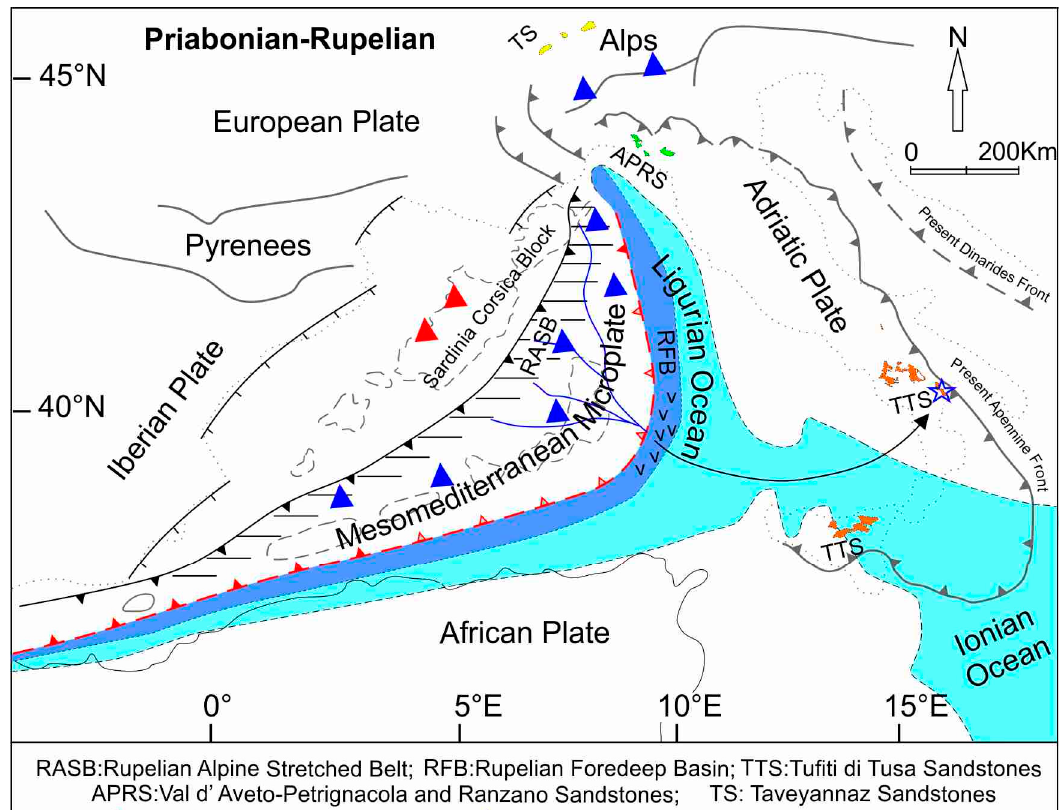
Figure 11. Redrawn paleogeographic sketch of the Western-Central Mediterranean area in the Priabonian-Rupelian age (modified from [2,20]). The Tufiti di Tusa sandstones were deposited in the Rupelian Foredeep Basin (RFB) near Mesomediterranean Microplate and far from the Sardinia-Corsica block. Symbols “vvv” represent the depositional domain of the volcaniclastic sandstones; blue star is the geographical location of the studied outcrops; blue lines indicate the drainage system. The Sardinia-Corsica volcanic activity was poor in the Priabonian–Rupelian times [6,10].